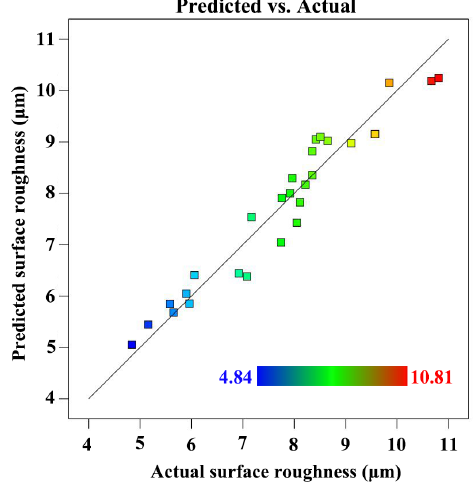
Figure 5. Correlation graphs for surface roughness.